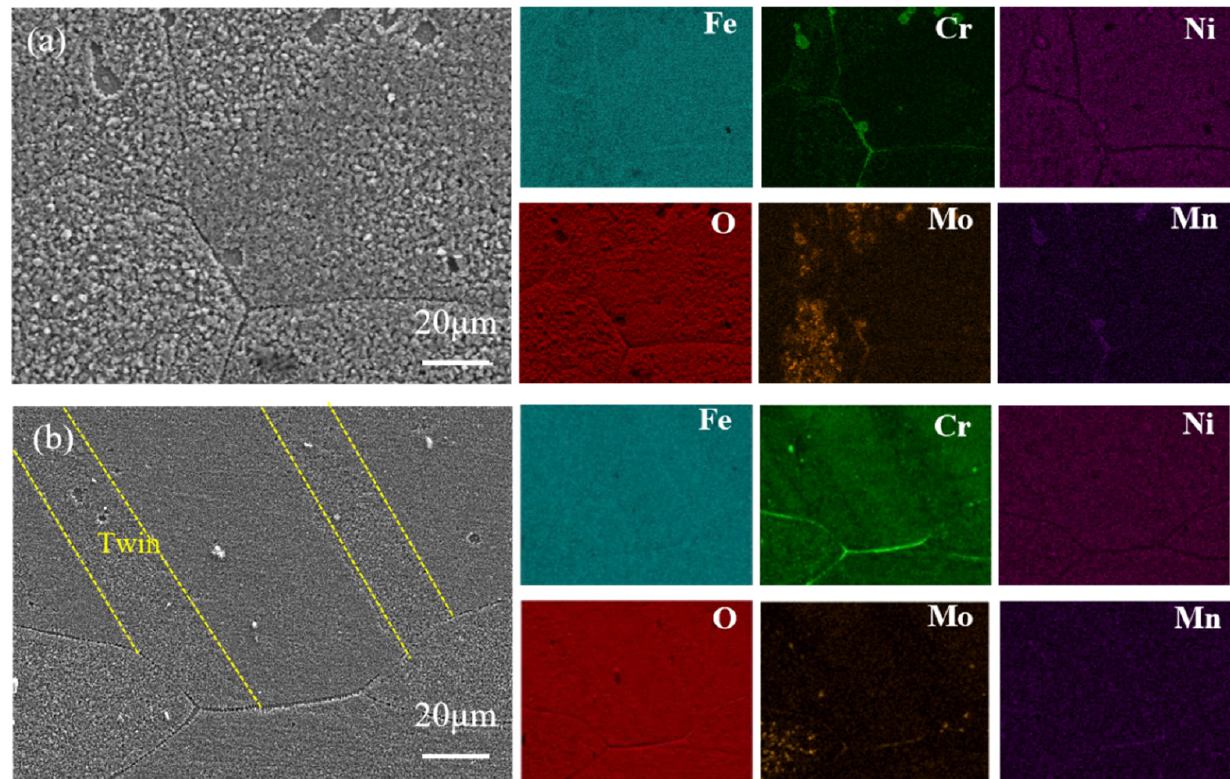
Figure 5. SEM surface morphologies and EDS analysis results of 254SMO–0B ( a ) and 254SMO–40B ( b ) samples after oxidation at 1000 °C for 1.5min.